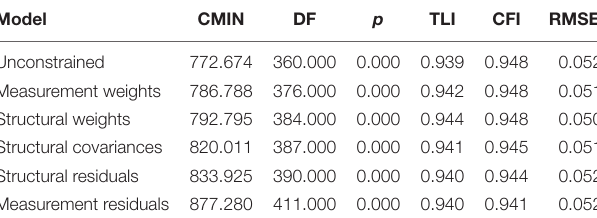
TABLE 7 | Fitting index of multigroup